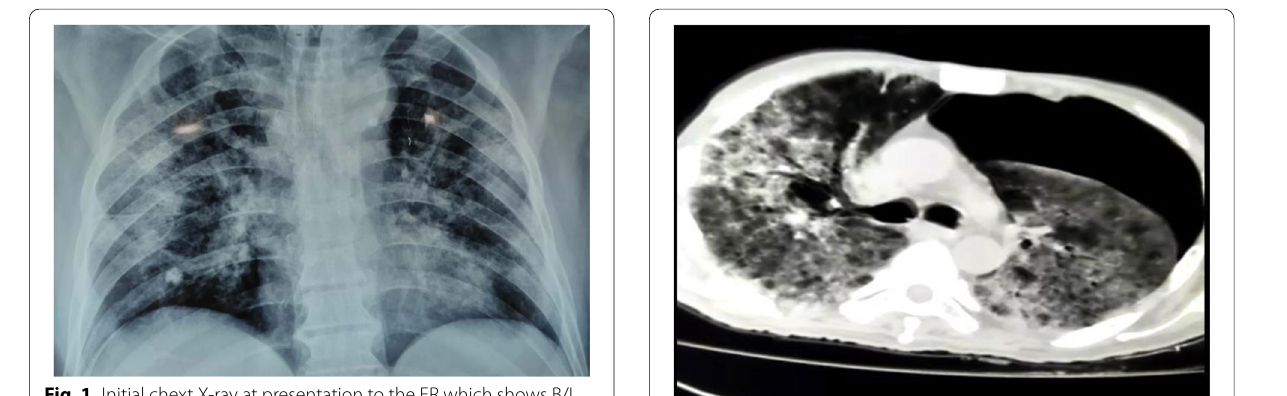
Fig. 1 Initial chext X-ray at presentation to the ER which shows B/L diffuse patchy infiltrates